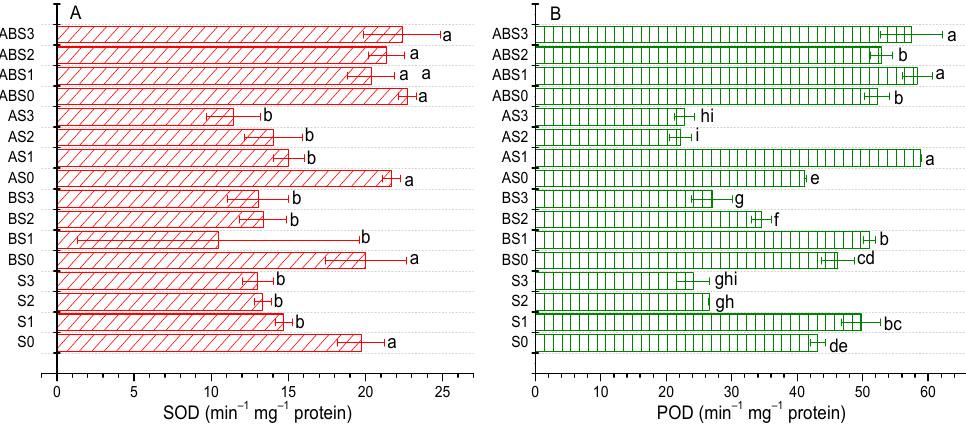
Figure 6. Impact of AMF and biochar on the activity of SOD ( A ) and POD ( B ) in maize under different levels of salinity. Data present the mean ± standard deviation of three replicates and mean values followed by different letters are significantly different at p < 0.05 according to Duncan multiple range test. The significance of acronyms is the same as in Figure 1.